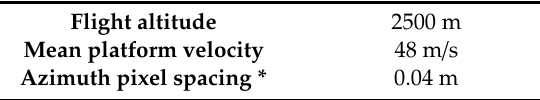
Table 4. SAR acquisition